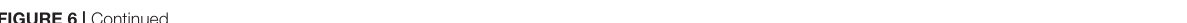
FIGURE 6 | Continued analyzed sperm population ± SEM. (E) Analysis of flagellar amplitude along the different regions of flagella (mid-piece, principal piece, and end piece) in sperm from Crisp4 wild type and knock out mice before and after exposure to 1 µ M recombinant CRISP4 protein. See Supplementary Table 8.1 for all the possible interactions between exposed and non-exposed genotype. (F) Analysis of power dissipation (10 − 12 J/s) along the different regions of flagella (mid-piece, principal piece, and end piece) in sperm from Crisp4 wild type and knock out mice before and after exposure to1 µ M recombinant CRISP4 protein. The data presented is from a total number of 10–15 sperm/genotype. *** indicates P < 0.001 as analyzed by two-way ANOVA ± SEM. **** indicates P < 0.0001 as analyzed by two-way ANOVA ± SEM. See Supplementary Table 8.2 for all the possible interactions between exposed and non-exposed genotype. All representative videos can be access via DOI: